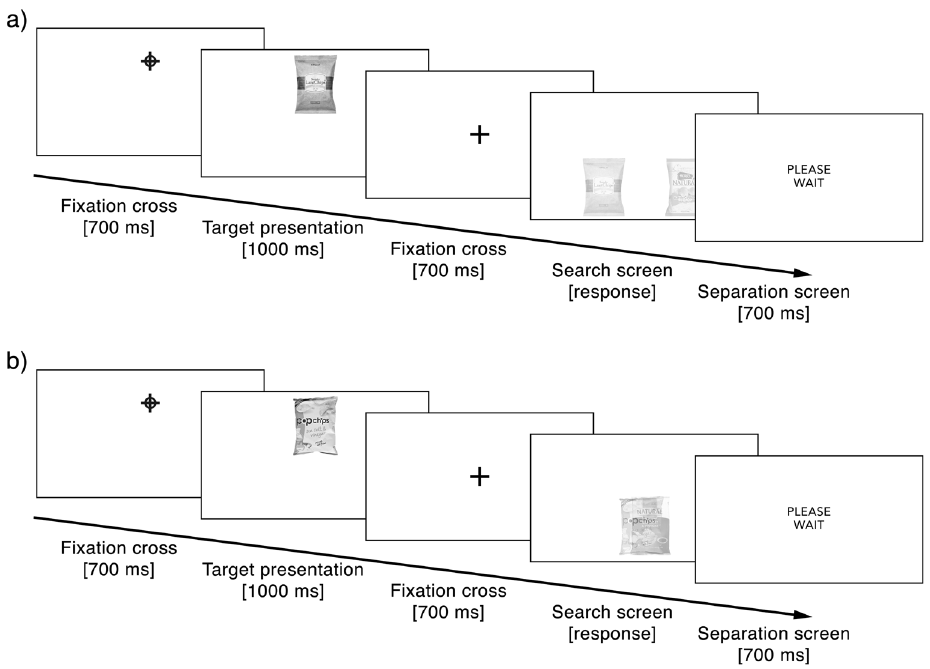
Figure 3. Exposure phase (Experiment 1). Example sequence of one search task during the exposure phase in Experiment 1 for ( a ) low competitive search and ( b ) highly competitive